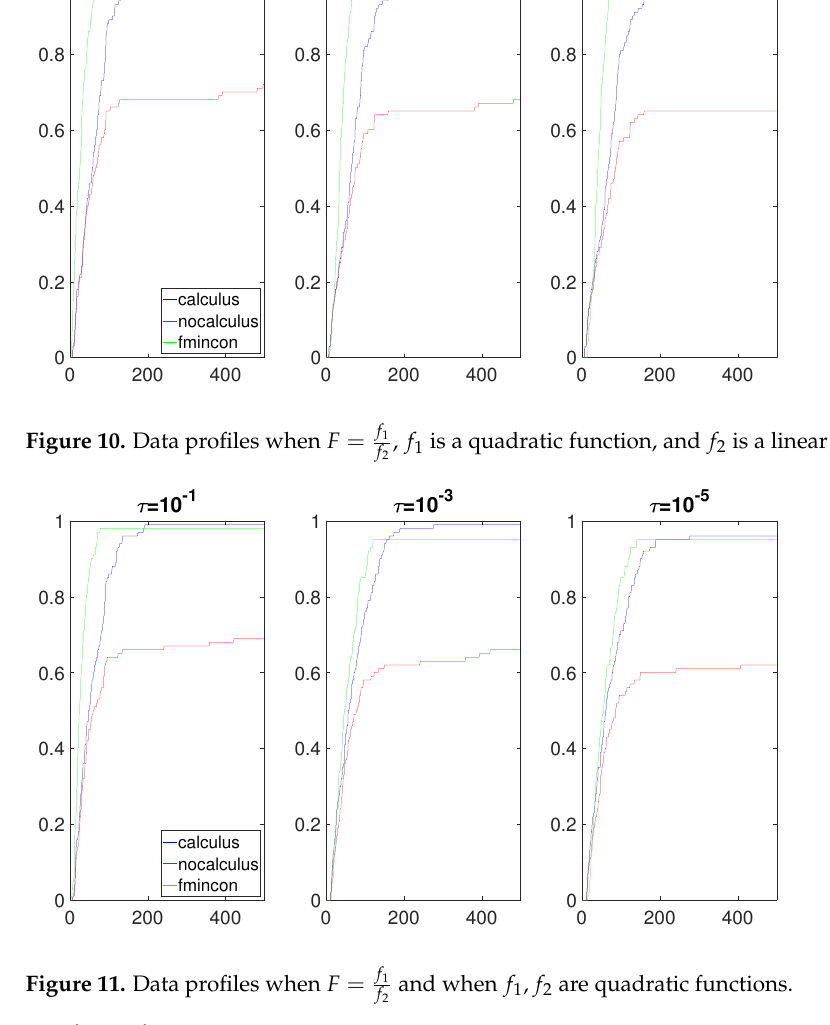
and when f 1 , f 2 are quadratic f 2